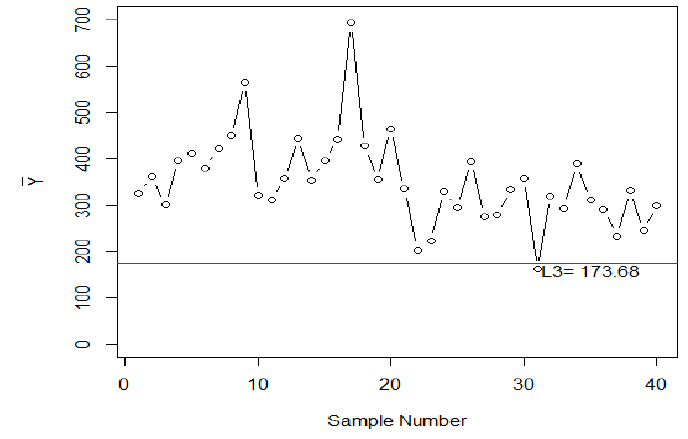
Figure 2. The proposed chart using simulated data.